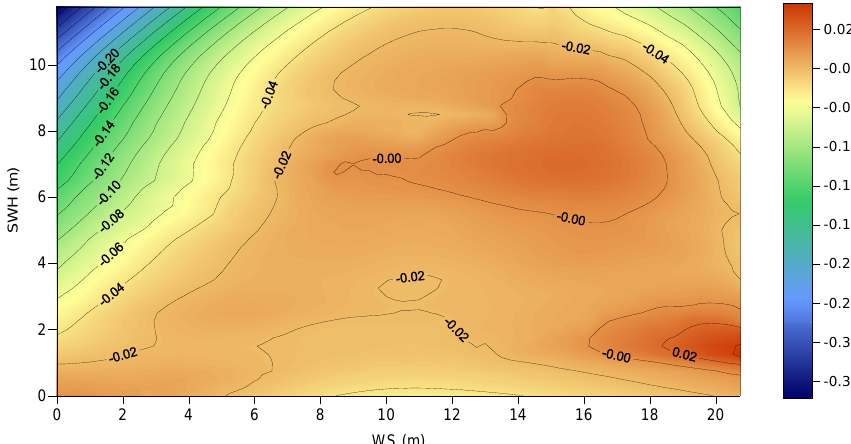
Figure 11c – Difference between Labroue and Chambers SSB models for TOPEX A